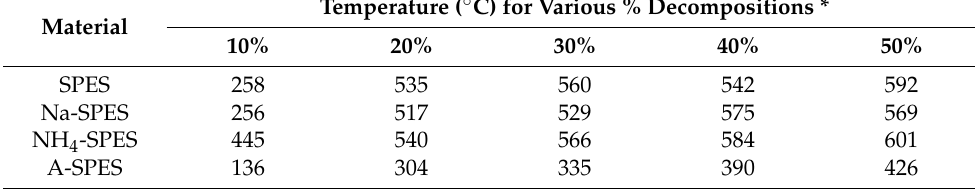
Table 1. Thermal properties of modified SPES membranes. Material